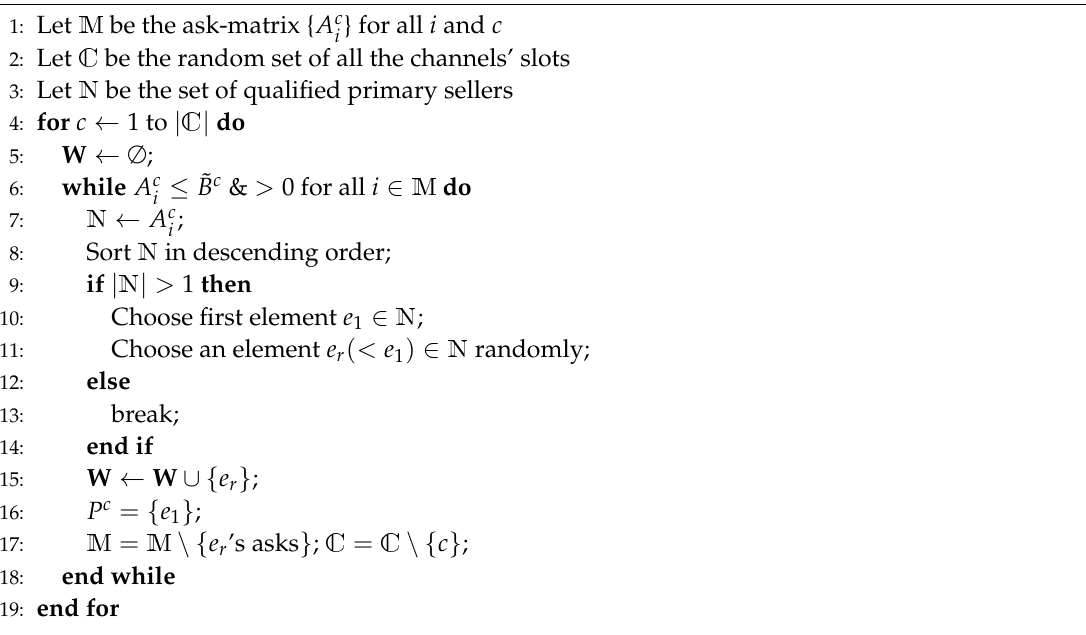
Algorithm 2 Outer-auction algorithm in